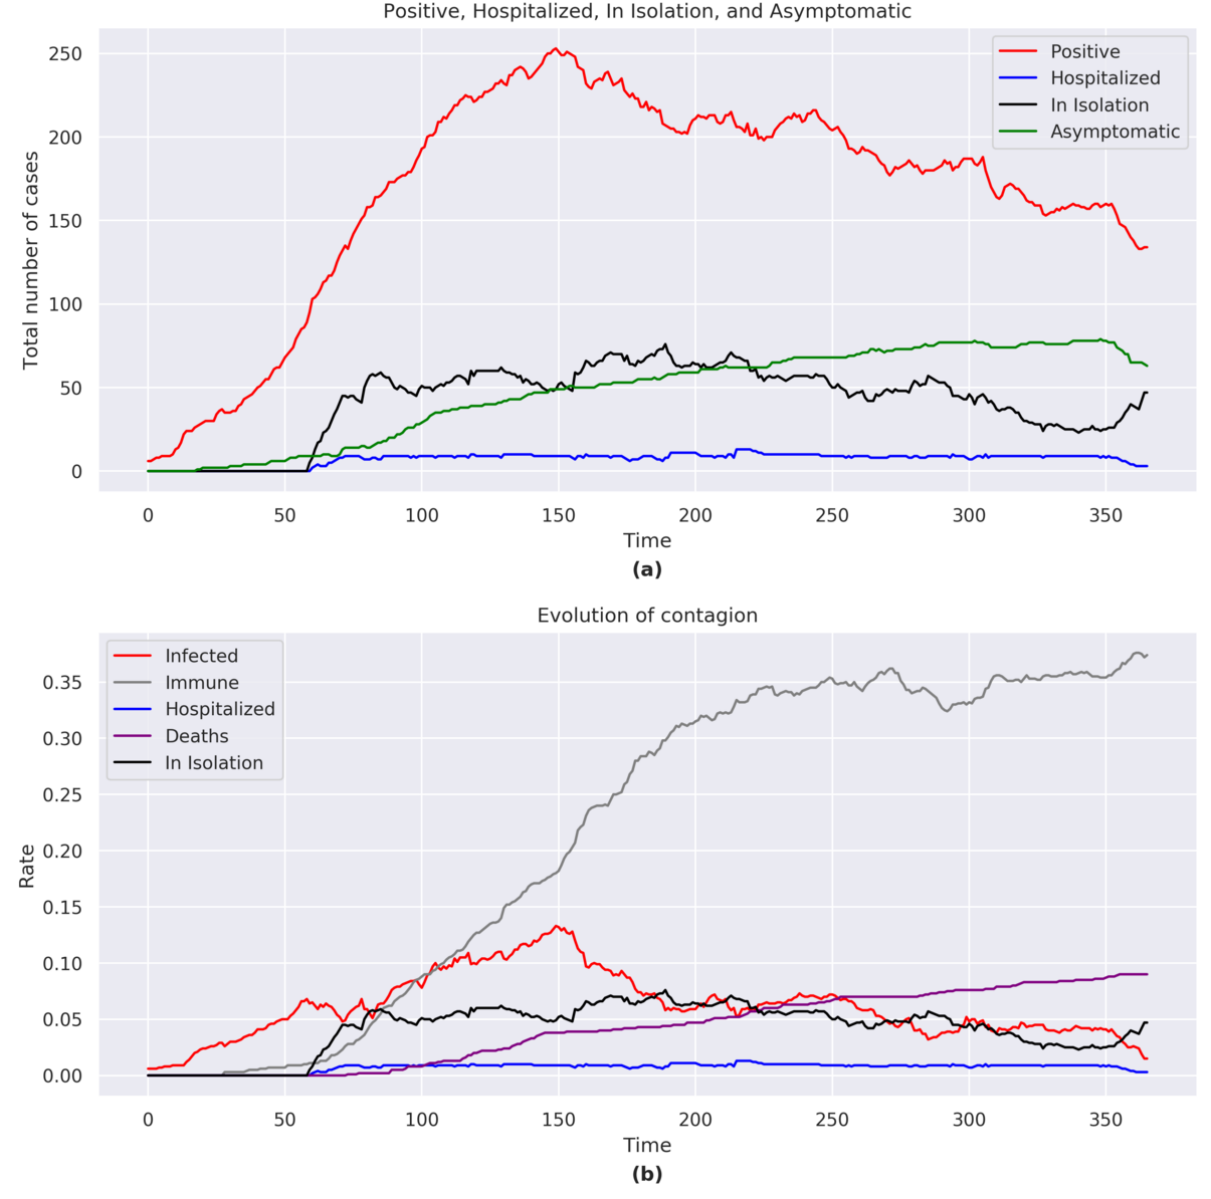
Figure 8. (a) Positive, hospitalized, in isolation, and asymptomatic figures for Brazil. (b) Evolution of the contagion for Brazil. The graphs consider the sum of the agents belonging to each category shown in the legend for each day of the